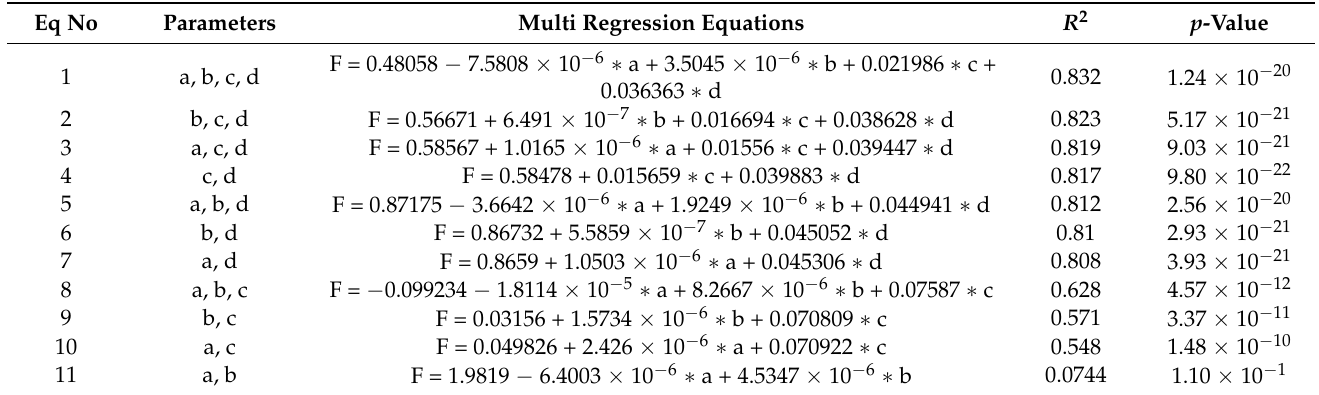
Table 4. Gokceada multiple subset parameters, regression equations, and R 2 performance.